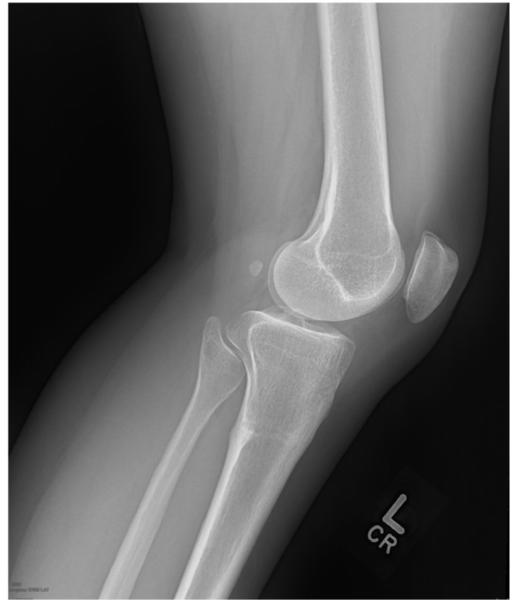
Figure 5. Post-treatment lateral radiograph demonstrating increased sclerosis of the site of the lesion. The treatment tract can be seen from anterior to posterior going toward the